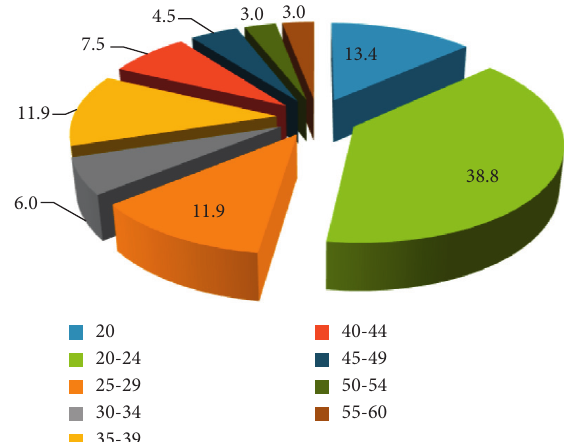
Figure 1: Age distribution of male drivers participating in driving simulator.